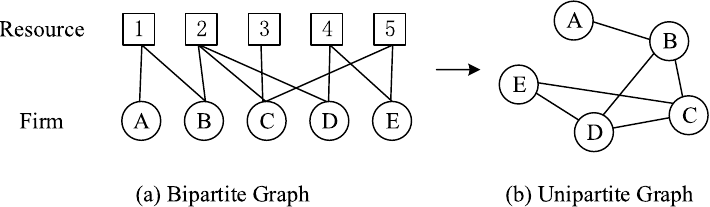
Fig. 3 A bipartite graph and a unipartite graph. The circular nodes A–E represent firms and the square nodes 1–5 represent resources